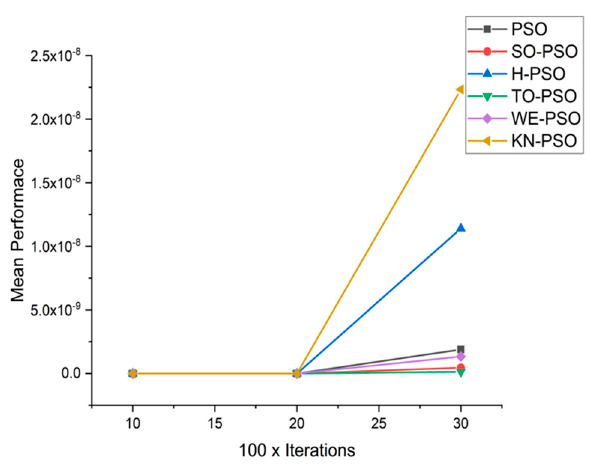
Figure 14. Convergence Curve on fn8.